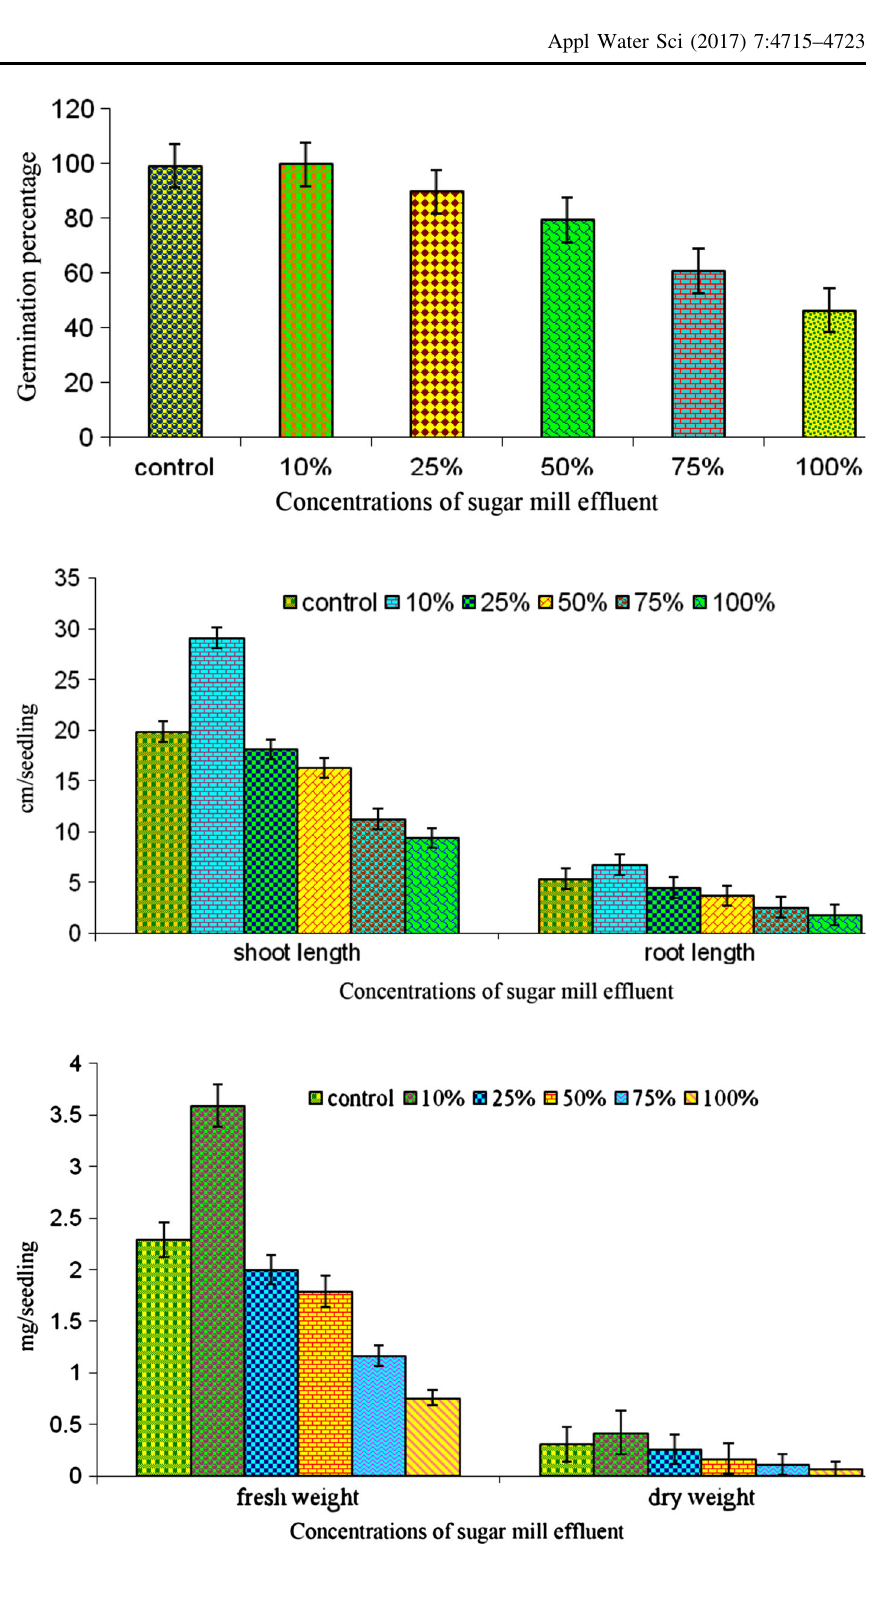
Fig. 1 Germination percentage of Tagetes erecta L. grown under different concentrations of sugar mill effluent